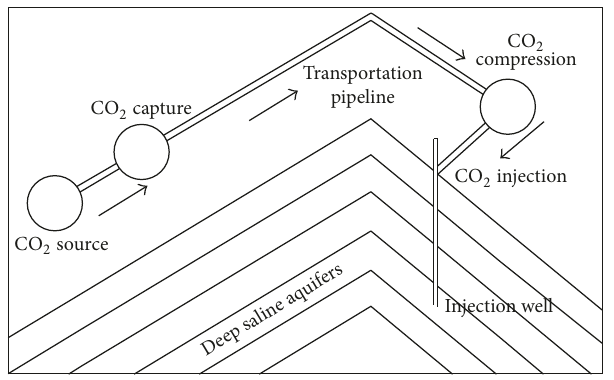
Figure 1: The process of CCS in deep saline aquifers.